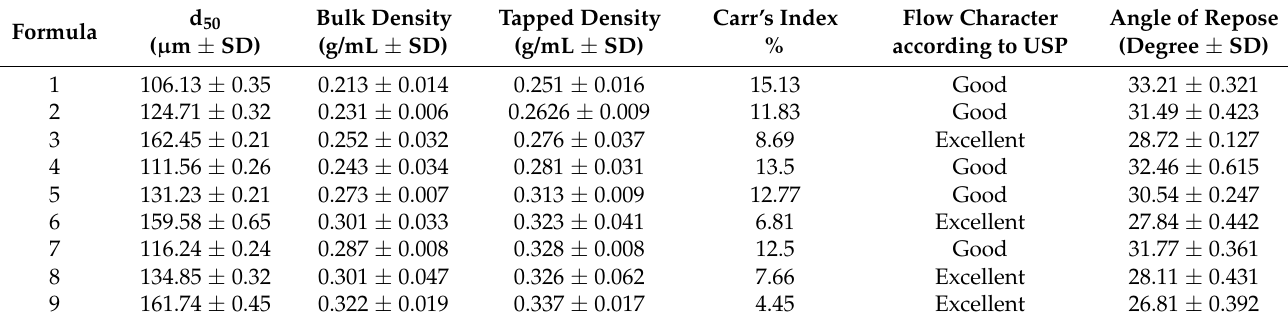
Table 5. Measured response results of prepared granules (mean ± SD).